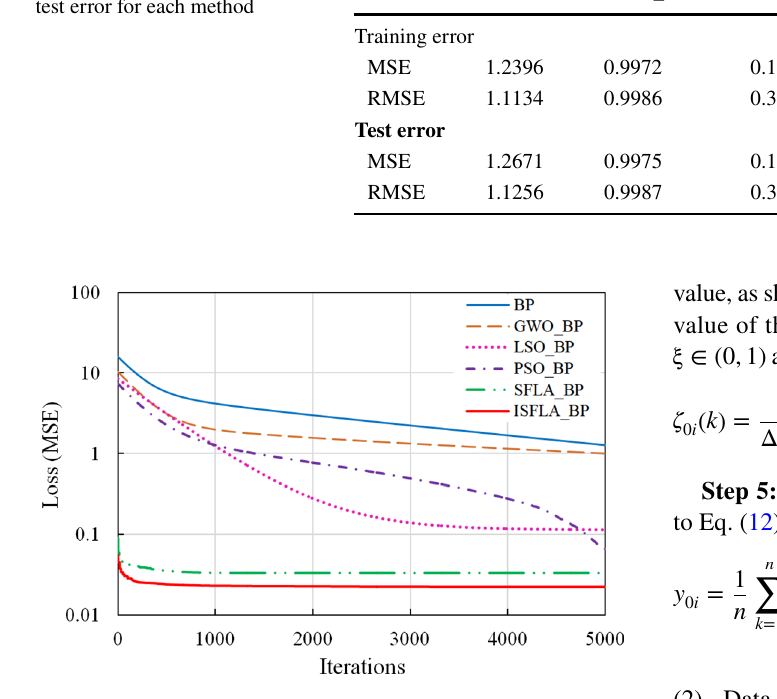
Fig. 8 Convergence curve of the iterative error